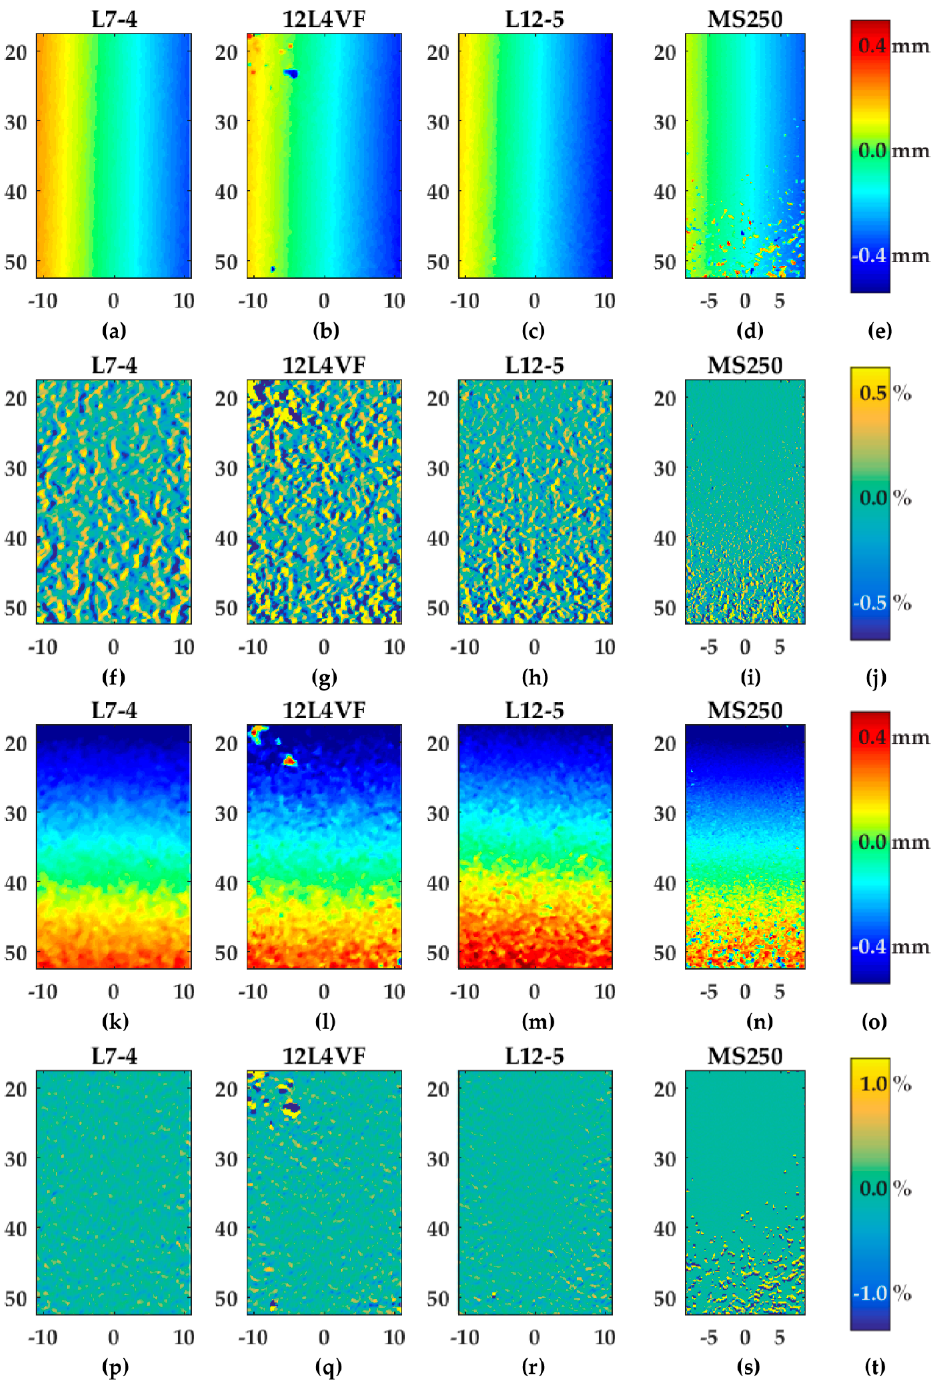
Figure 6. Overview of displacement and strain fields after rotation using Lu’s-fk and two lines per pitch as a beam-forming strategy and for line density, respectively: ( a – c ) axial displacements; ( f – n ) axial strains ( s zz ); ( k – n ) lateral displacements; ( p – s ) lateral strains ( s xx ); ( e , o ) color bar in millimeters related to the figures in the same row; ( j , t ) color bar in percentages related to the figures in the same row. The axis of the displacement and gradient fields represents the position below the transducer in millimeters.